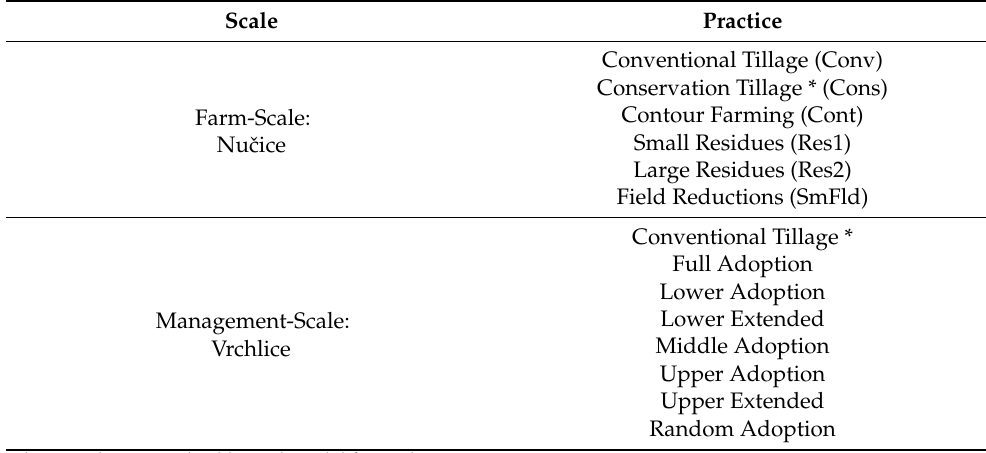
Table 3. Outline of scenarios implemented in the Nučice and Vrchlice Basins. (* denotes the original calibrated model for each).